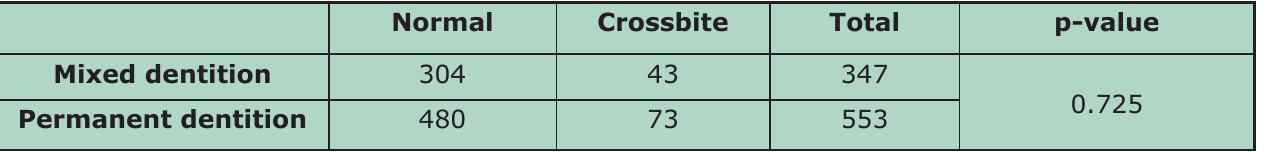
Table-III: Prevalence of crossbite in mixed and